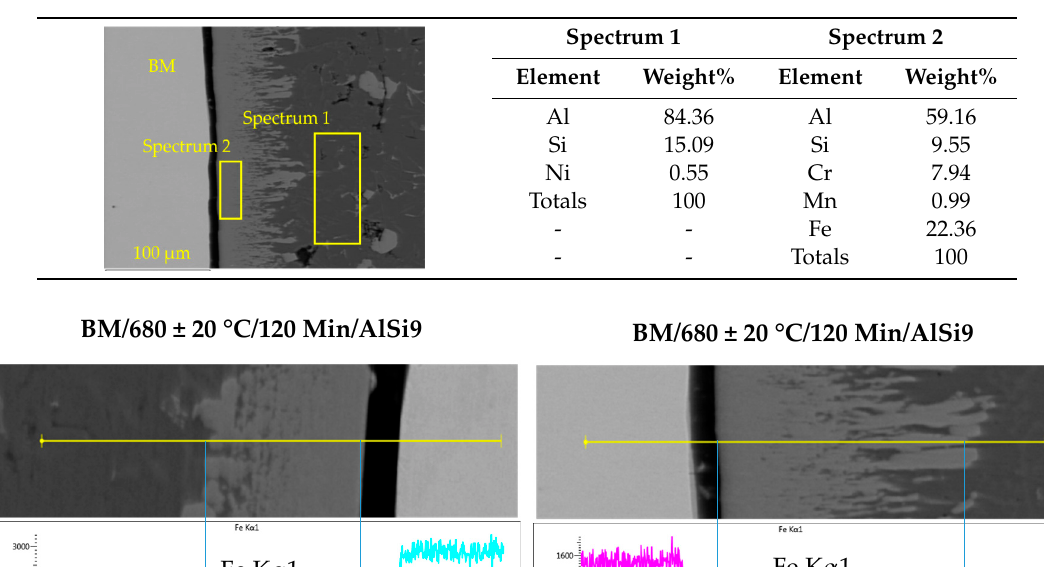
Table 12. BM / 680 ± 20 ◦ C / 300 min / ENAC-AlSi9. EDX semi-quantitative microanalyses.